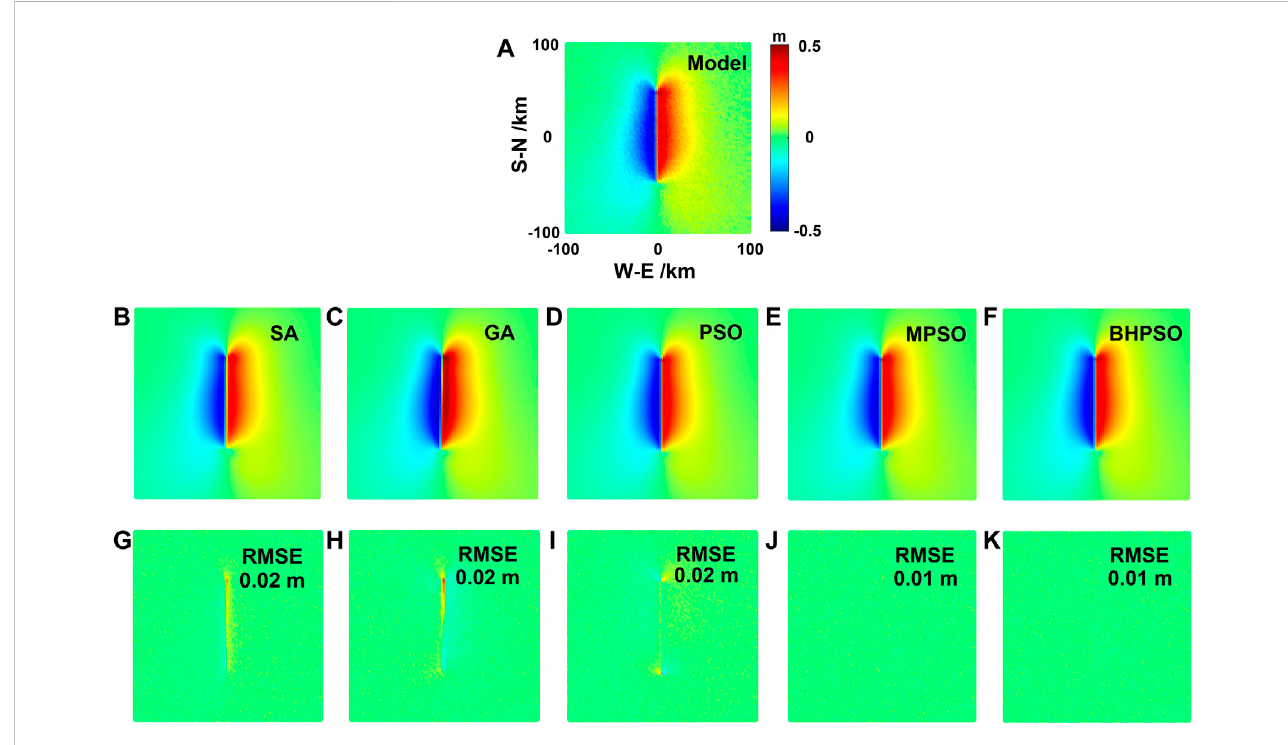
The comparisons of surface horizontal deformation (InSAR data) of the Okada model results from the pure strike-slip fault earthquake by using fault parameters given by the model and inversed from fi ve methods in Table 1. The surface horizontal deformation obtained by model (A) , SA method (B) , GA method (C) , PSO method (D) ,MPSO method (E) , andBHPSO method (F) . The residual ofsurfacehorizontaldeformation between the results ofmodel and SA method (G) , model and GAmethod (H) , model and PSO method (I) , model and MPSO method (J) , model and BHPSO method (K) . The bluearrowsshow the simulated surface horizontal deformation by the model in Table 1. The red arrows show the simulated surface horizontal deformation by using the fault parameters inversed from the fi ve methods. The black arrows show the fi tting residuals. The positive value in color bar is the deformation away from the satellite, while the negative value is the deformation close to the